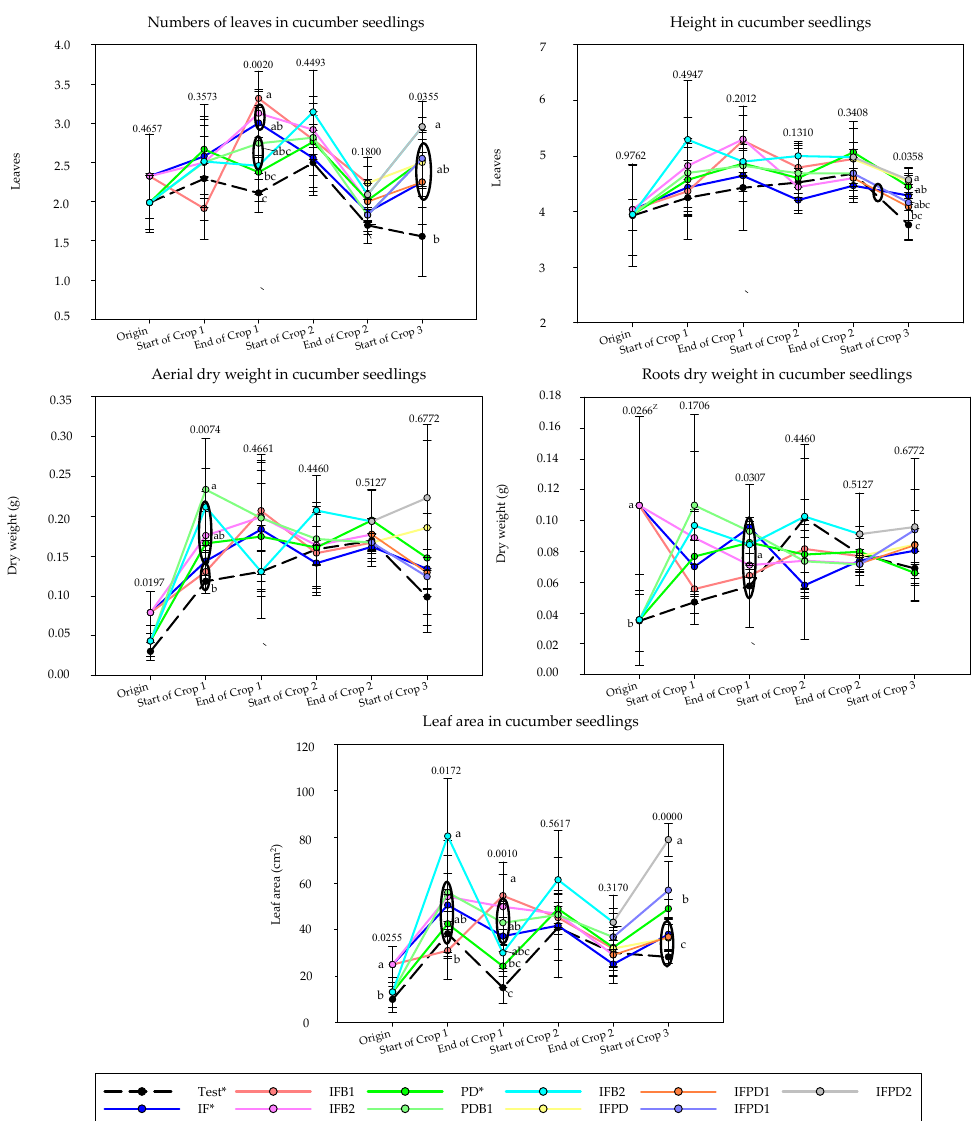
Figure 2. Number of leaves, height, aerial dry weight, root dry weight, and leaf area of cucumber seedlings grown in a controlled environment chamber. Values (mean ± standard deviation). Different letters indicate significant differences ( p ≤ 0.05, Tukey’s HDS test; z: √𝑥 ). No fertilization (test); inorganic fertilization (IF); inorganic fertilization + 0.5 kg·m −2 of Brassica carinata pellets (IFB1); inorganic fertilization + 1.0 kg·m −2 of Brassica carinata pellets (IFB2); 3.5 kg·m −2 of tomato plant debris (PD); 3.5 kg·m −2 of tomato plant debris + 0.5 kg·m −2 of Brassica carinata pellets (PDB1); 3.5 kg·m −2 of tomato plant debris + 1.0 kg·m −2 of Brassica carinata pellets (PDB2); inorganic fertilization + 3.5 kg·m −2 of tomato plant debris (IFPD); inorganic fertilization + 5 kg·m −2 of tomato plant debris (IFPD1); 5 kg·m −2 of tomato plant debris (PD1); 6.5 kg·m −2 of tomato plant debris (PD2). * Source: own elaboration based on Castillo-Díaz et al. [23].